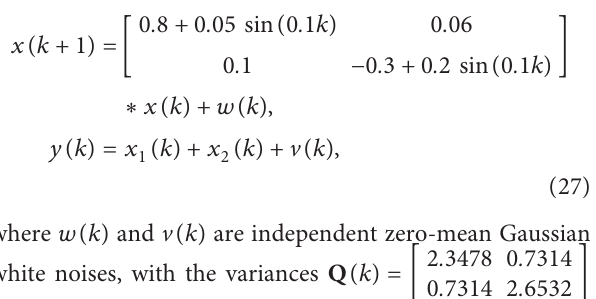
Figure 3: Estimation curve for state 1.